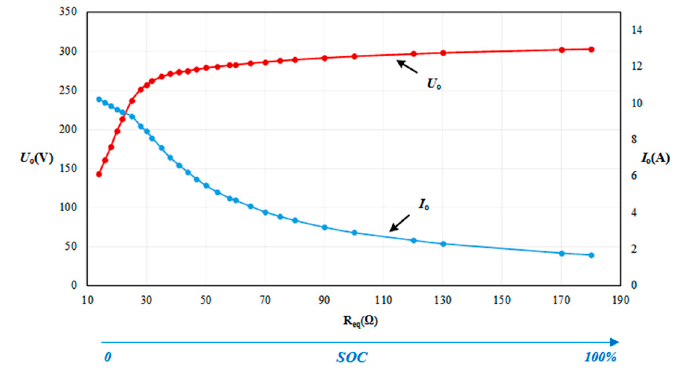
Figure 23. System output curves in open loop.